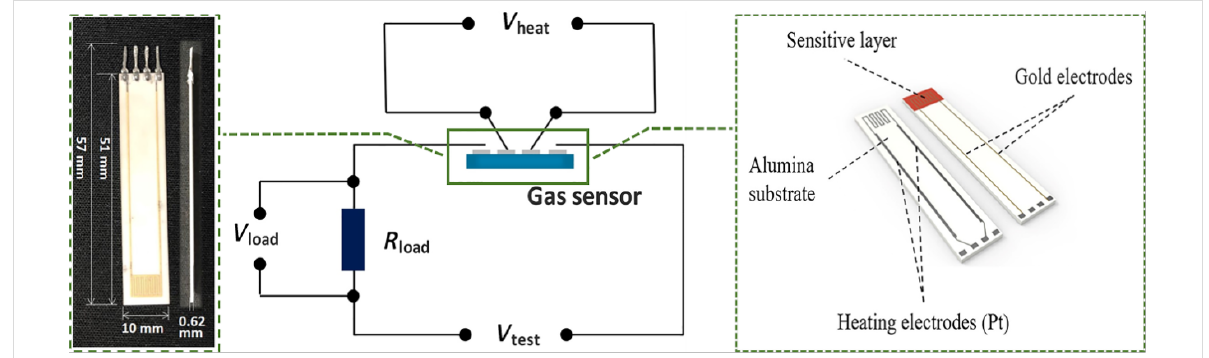
Figure 1: Schematic images of the electric circuit equivalent to the system and the corresponding ZnFe 2 O 4 /rGO sensor.